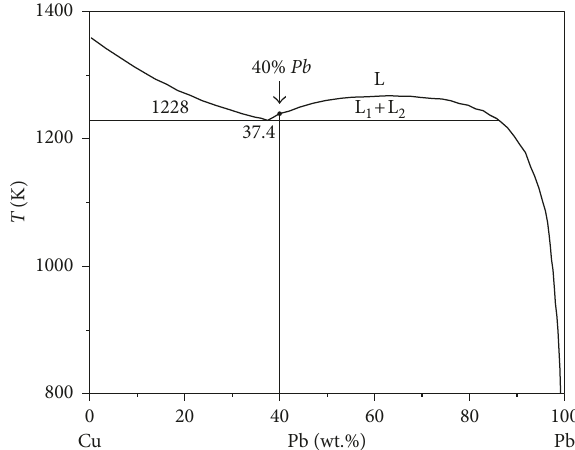
Figure 1: Phase diagrams of Cu-Pb monotectic alloys [15].